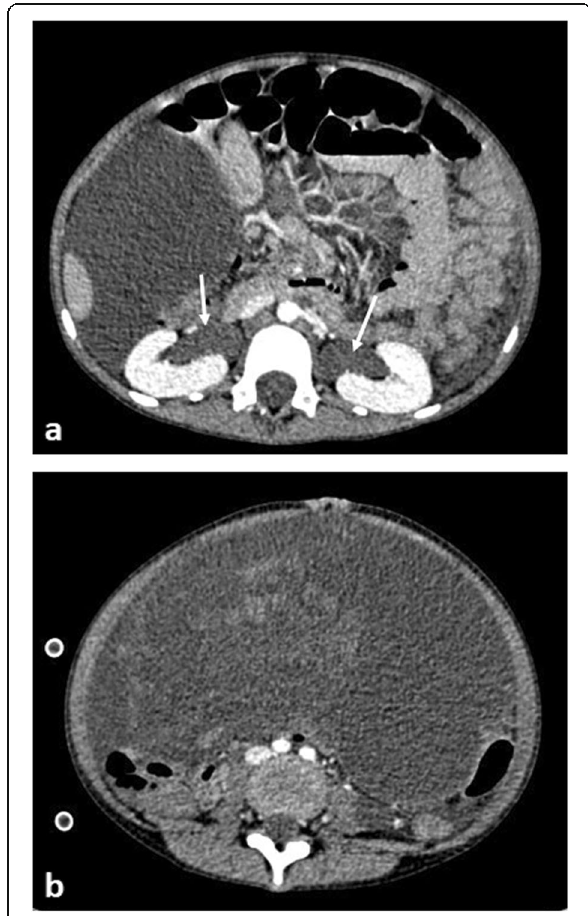
Fig. 17 An 8-year-old girl with large Sertoli Leydig cell ovarian tumour arising from the right ovary. a Axial contrast-enhanced CT of the upper abdomen demonstrates bilateral hydronephrosis (white arrows) secondary to ( b ) the large intra-abdominal mass, which was compressing the distal ureters (not visible in